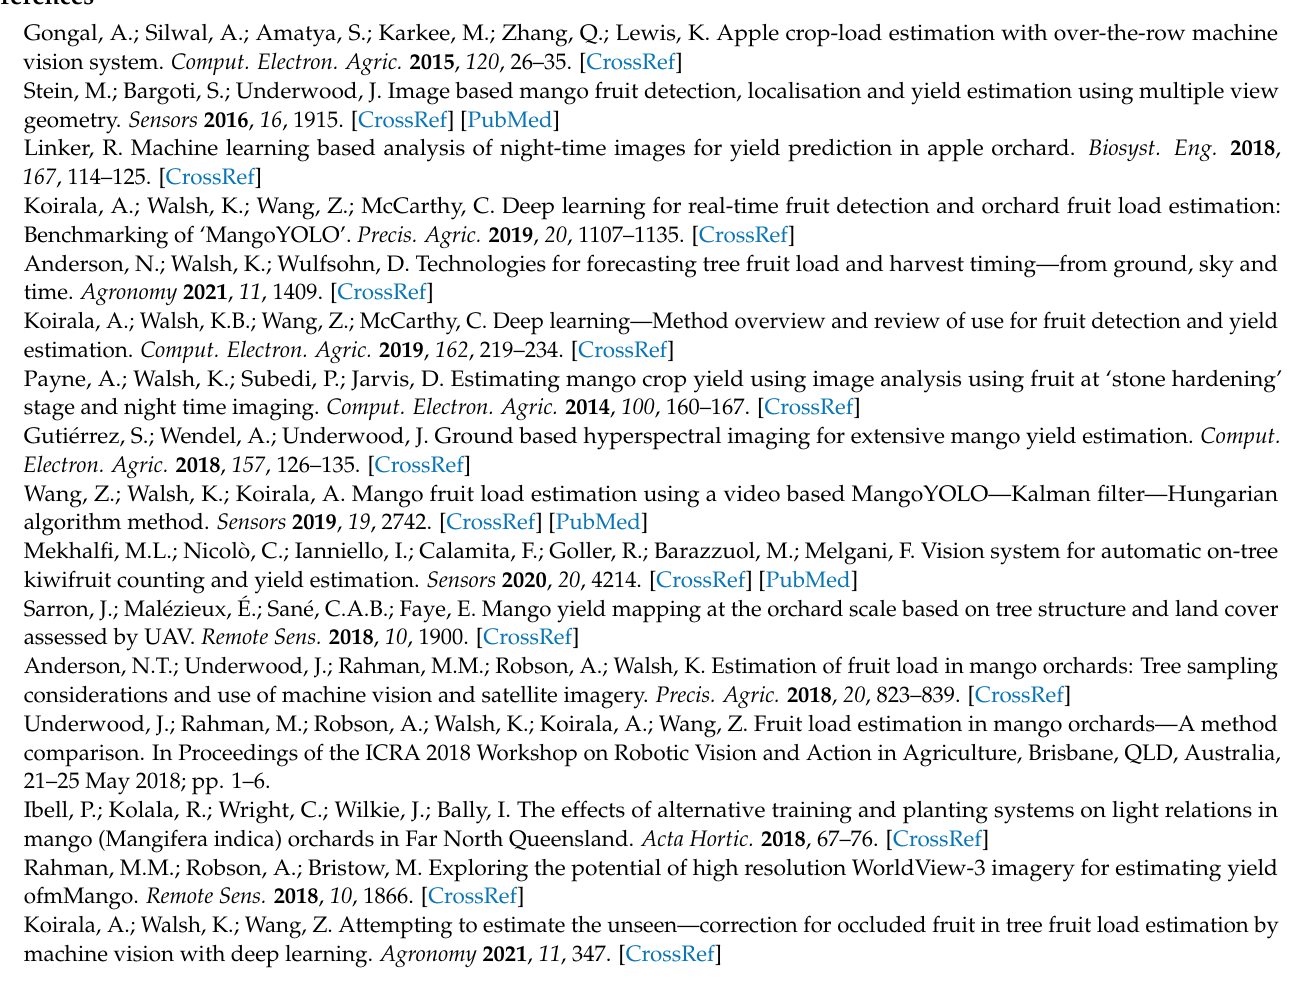
Figure A1. Percentage of mean square error (MSE) attributed to five orchard attributes (tree age, SD and mean of tree crown area, inter-row and tree spacing) for the prediction of the ratio of multi view machine vision (MV) to packhouse counts using a Random Forest model. There remains a need to develop better tools for estimation of an occlusion factor for a given orchard.